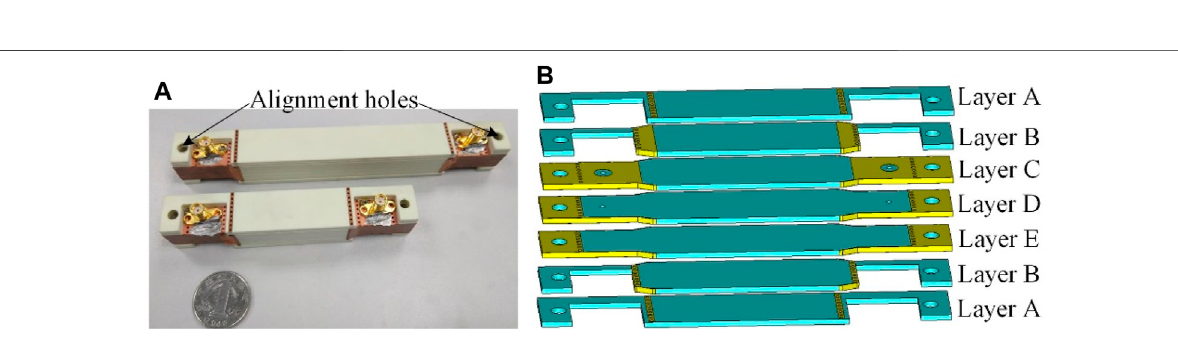
FIGURE 2 | Electric fi eld distribution at 8 GHz of the designed dielectric rod waveguide and the conversion structure. (A) XOZ plane. (B) XOZ plane.